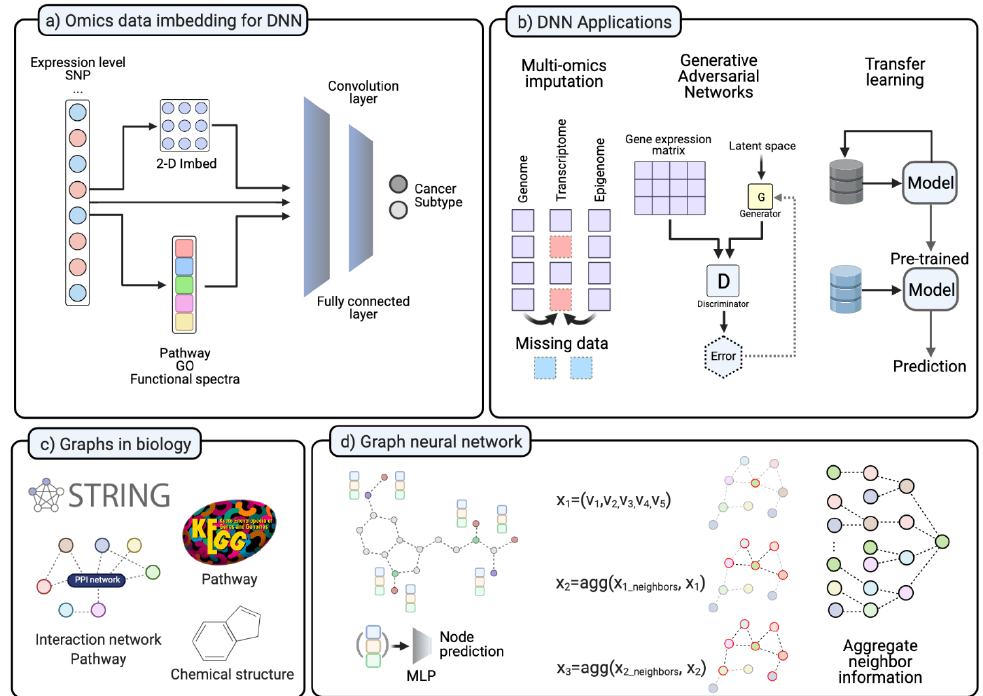
Figure 3. ( a ) In various studies, NGS data transformed into different forms. The 2-D transformed form is for the convolution layer. Omics data is transformed into pathway level, GO enrichment score, or Functional spectra. ( b ) DNN application on different ways to handle lack of data. Imputation for missing data in multi-omics datasets. GAN for data imputation and in silico data simulation. Transfer learning pre-trained the model with other datasets and fine-tune. ( c ) Various types of information in biology. ( d ) Graph neural network examples. GCN is applied to aggregate neighbor information. (Created with